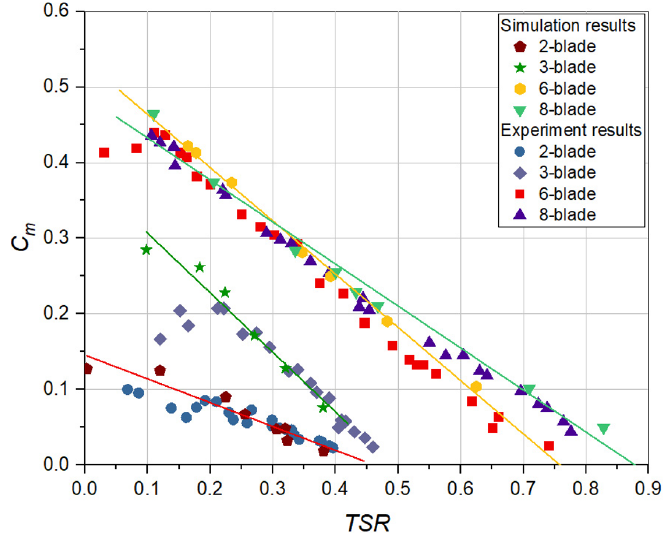
Figure 13. Effect of the number of blades on the moment coefficient for different TSR values (experi- mental and simulation